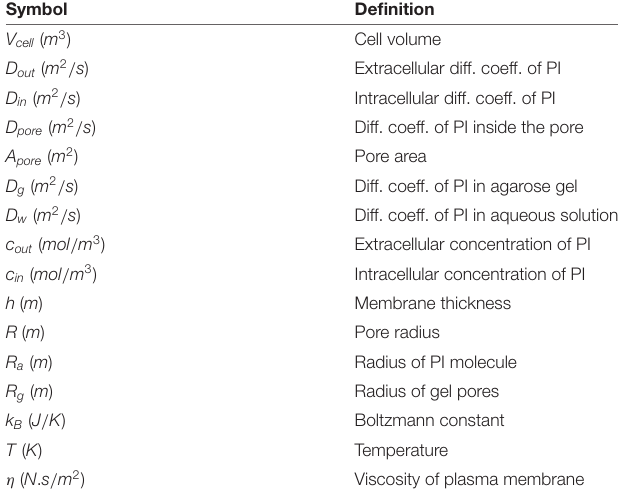
TABLE 1 | Definition of symbols.